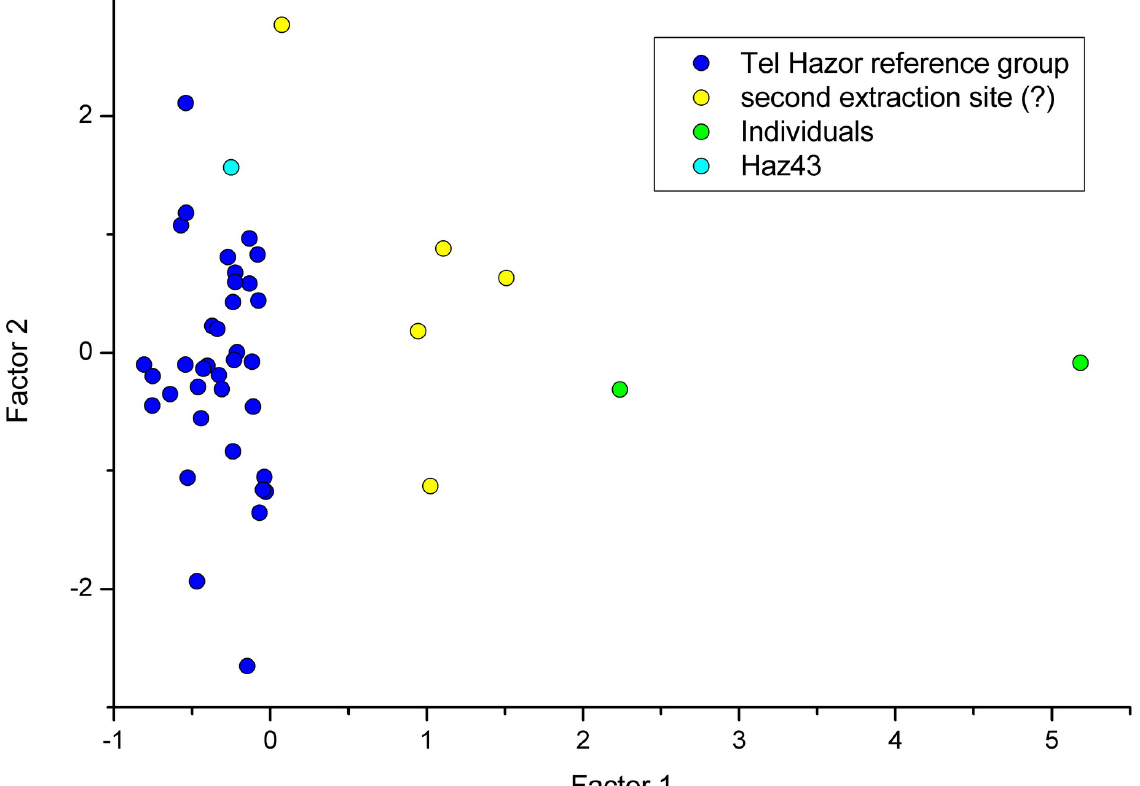
Figure 7. Combination of PCA and CA results: First two principal components. The dark blue spots are the samples clustered into the dominant Tel Hazor group. The light blue spot is sample Haz43. The yellow samples possibly represent a second minor extraction site. The green samples are the basanites, which show no connection to any